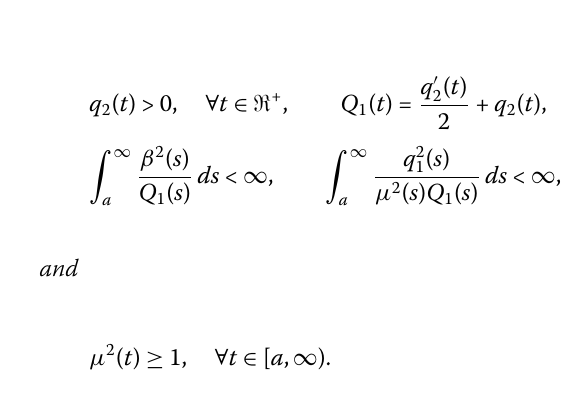
Figure 4 Trajectory of y ( t ) for Example 1 when x (2) = 0 and y (2) =